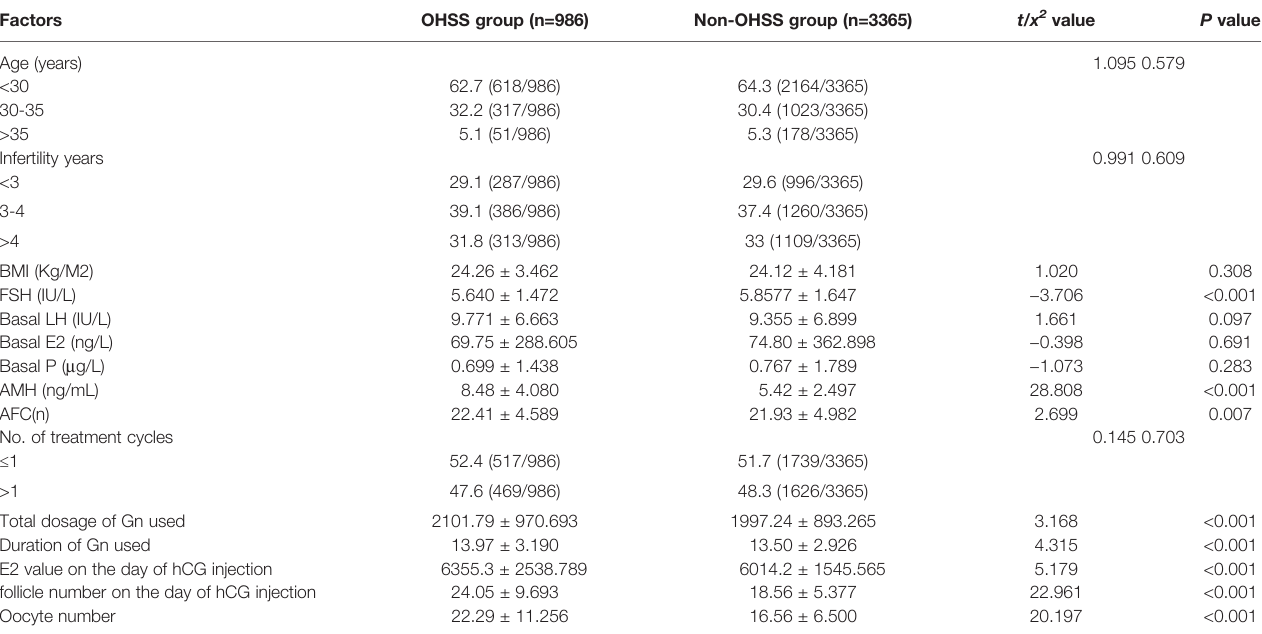
TABLE 1 | Comparison of clinical characteristics in the PCOS patients with and without OHSS.